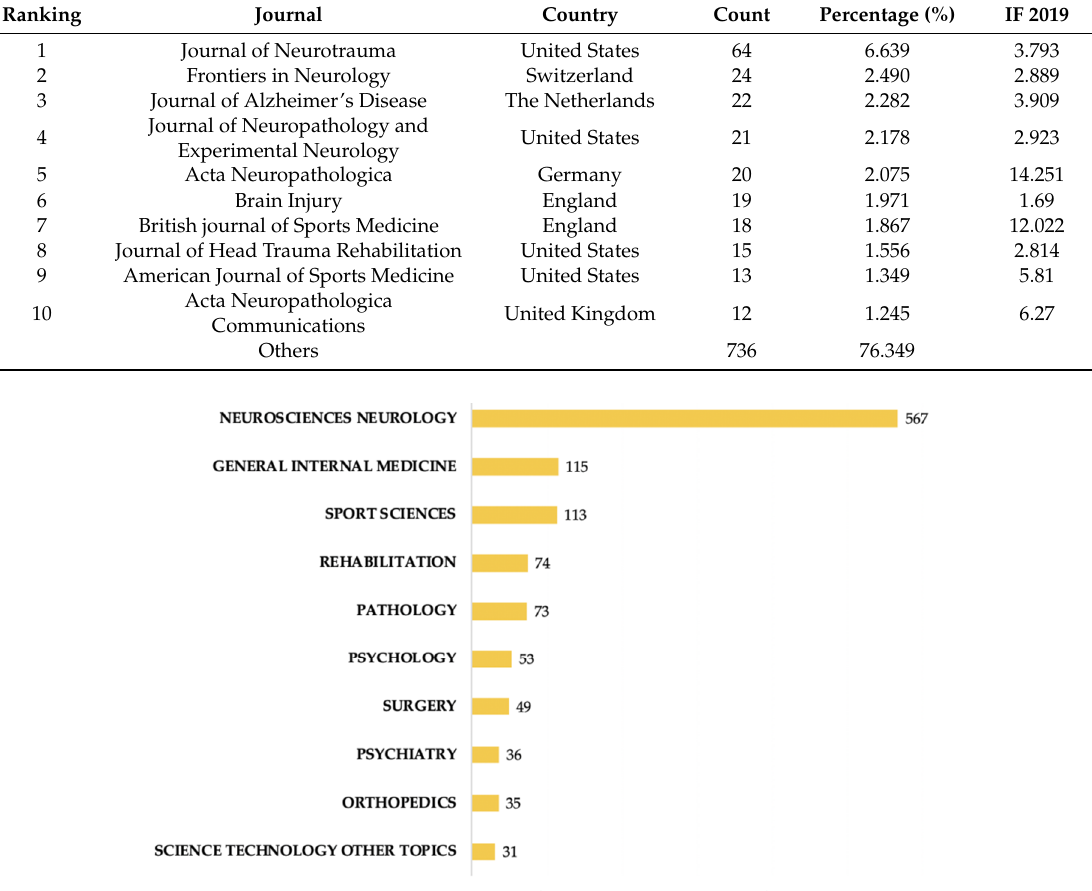
Table 2. Ranking of top 10 active journals that published articles on CTE research from 1999 to 2019.